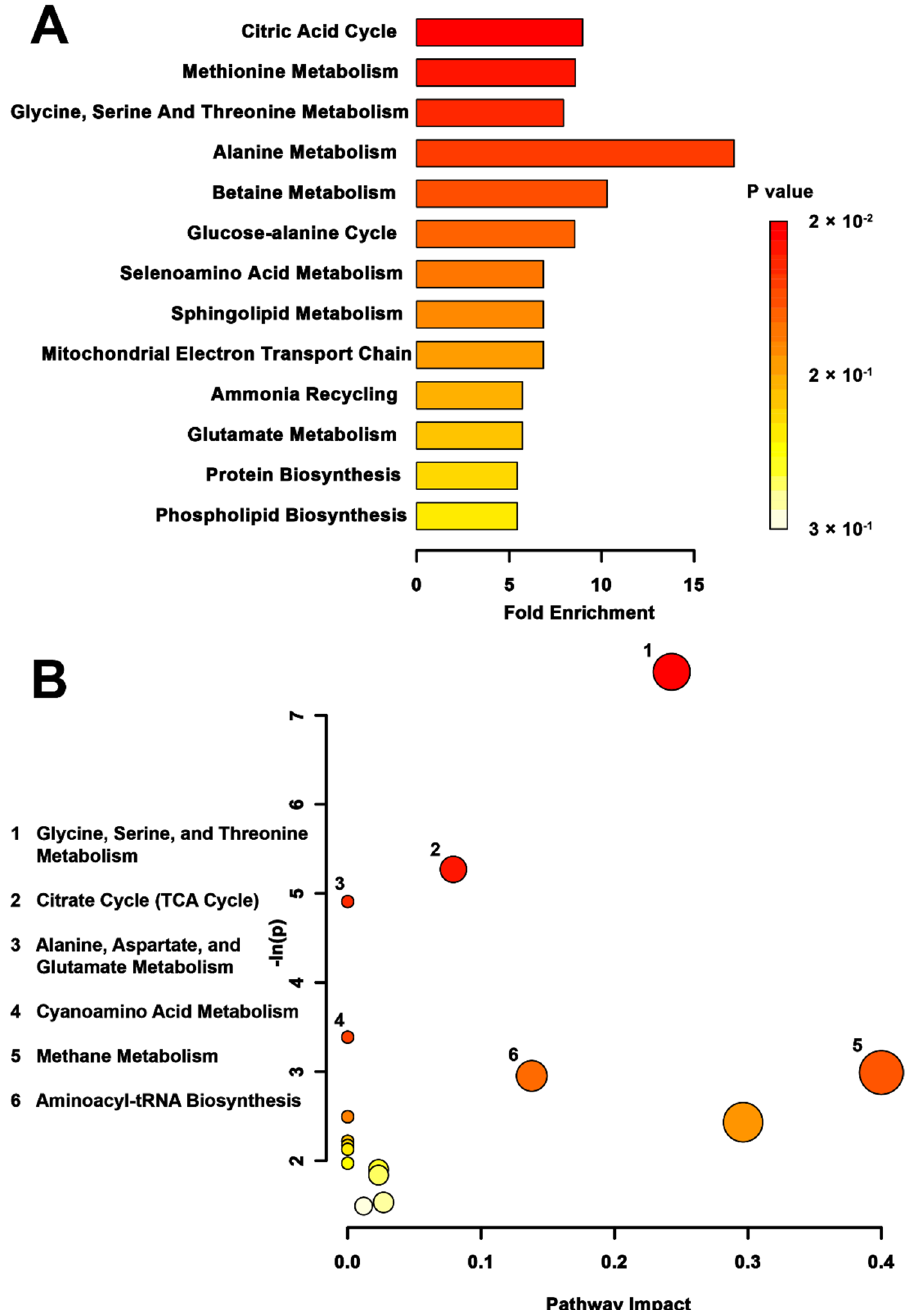
Figure 4. Pathway-associated metabolite set enrichment analysis (MSEA) for TPS vs. MPS. ( A ) Plot showing affected biological processes in transgenerationally stressed (TPS) compared to multigenerationally stressed (MPS) rats, based on metabolites identified as significantly altered between these groups. The p -value for each pathway is shown using the heatmap on the right of the figure and the fold enrichment shows how many times greater than chance the process is involved. ( B ) Metabolomic pathway analysis showing all matched pathways according to p -values from pathway enrichment analysis and pathway impact values from pathway topology analysis in TPS vs. MPS rats. The y-axis shows the negative natural log of p , such that a higher value on the y-axis gives a lower p -value. The x-axis indicates the pathway impact, which correlates to the number of metabolite hits in a particular pathway. Only metabolic pathways with p < 0.05 are labeled. The largest difference in pathway activity between TPS and MPS was observed in the glycine, serine, and threonine metabolism.